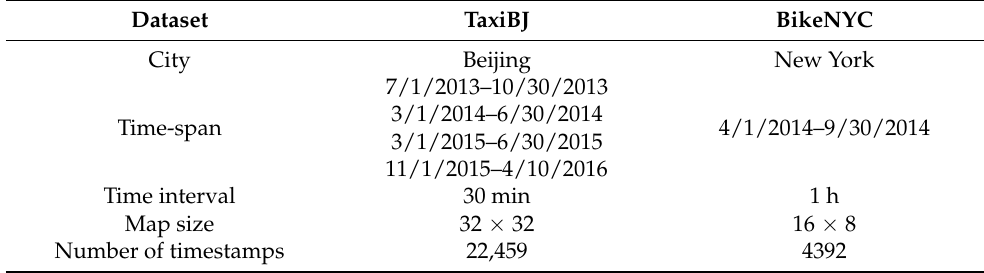
Table 2. Details of the